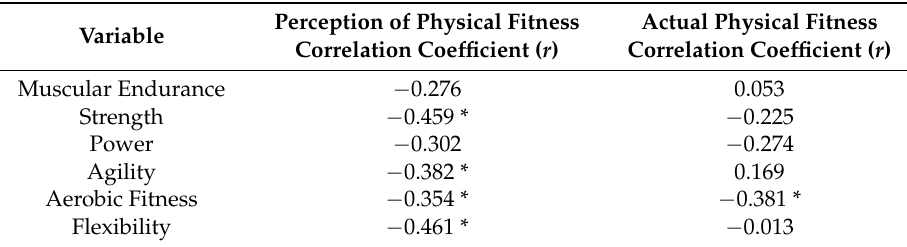
Table 3. Pearson correlations between BD and Perception of Physical Fitness and Measured Physical Fitness Scores.